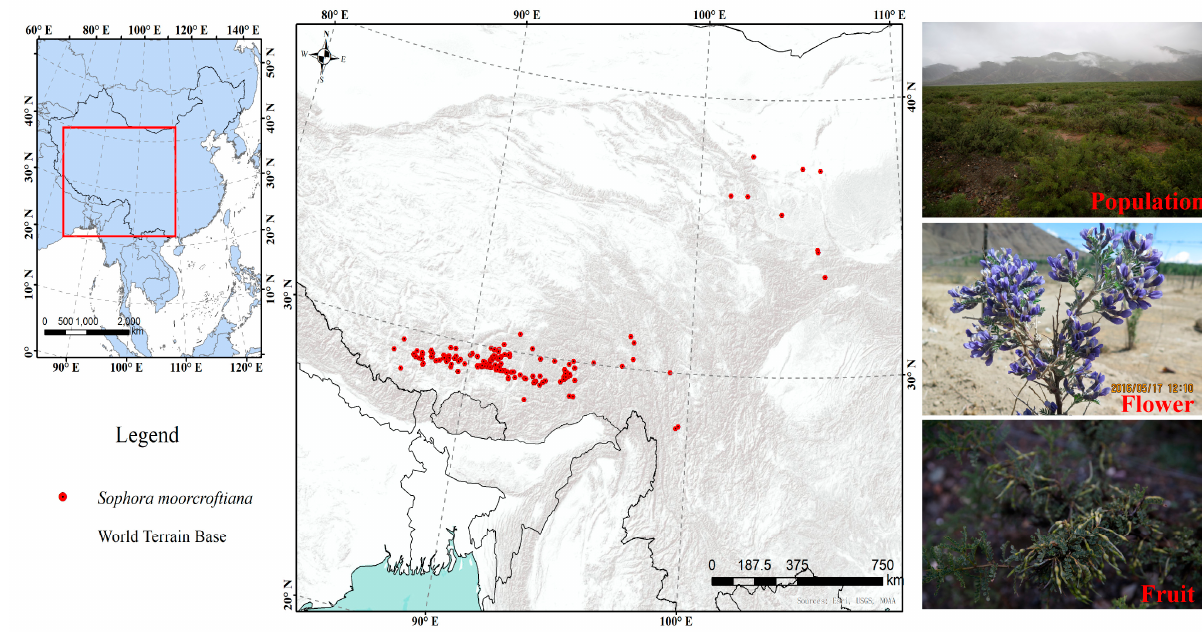
Figure 1. The spatial distribution of S. moorcroftiana (Benth.) Baker population occurrence records across the Tibetan Plat- eau.